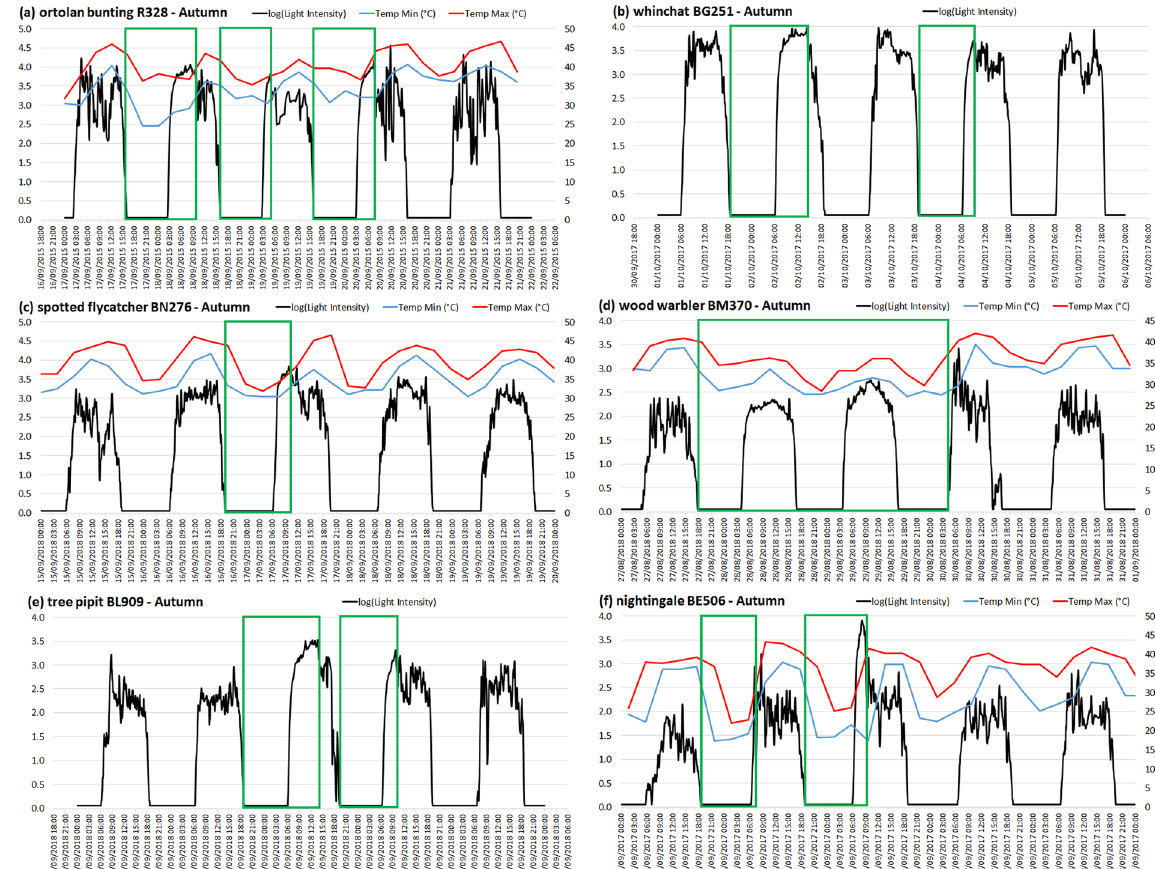
Figure 1. Light intensity (log-transformed), minimal and maximal temperatures (if available) recorded by geolocators during autumn desert crossing for six individuals of different species. Green rectangles represent possible flight bouts. ( a ) ortolan bunting R328: FLP during three consecutive days; ( b ) whinchat BG251: long FLP on second day and short FLP on fourth day, so not on consecutive days; ( c ) spotted flycatcher BN276: FLP in the third day, with lower temperatures in the morning of that day. ( d ) wood warbler BM370: non-stop flights during three nights and two days, revealed by complete FLPs and low temperatures; ( e ) tree pipit BL909: third and fourth days with obvious FLPs; no temperature data available. ( f ) nightingale BE506: two nights with large drops in minimal and maximal temperatures, the second followed by a short FLP, corresponding to a low minimal temperature saved at 9:39, so recorded during the four previous hours (5:39–9:39), while sunrise occurred at